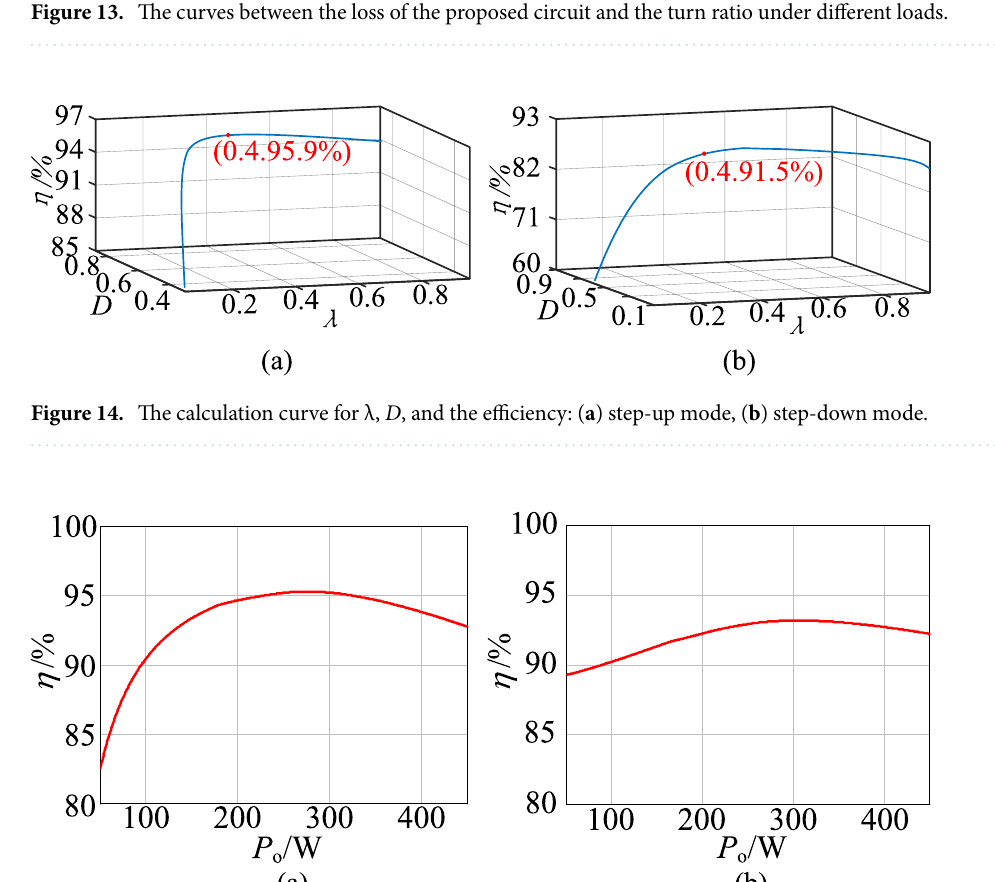
Figure 13. The curves between the loss of the proposed circuit and the turn ratio under different loads.